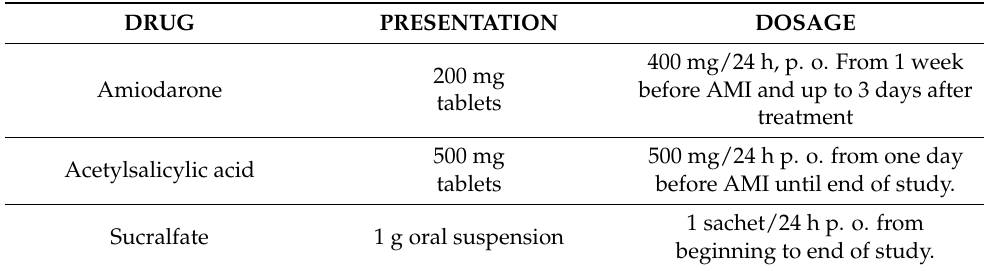
Figure 1. Experimental design. SAL: Saline group; MS: Placebo microspheres group; MS+HGF: Microencapsulated HGF group; AMI: Acute Myocardial Infarction; IC: Intracoronary; TTC: Triphenyltetrazolium chloride. Table 1. Preventive drug therapy.